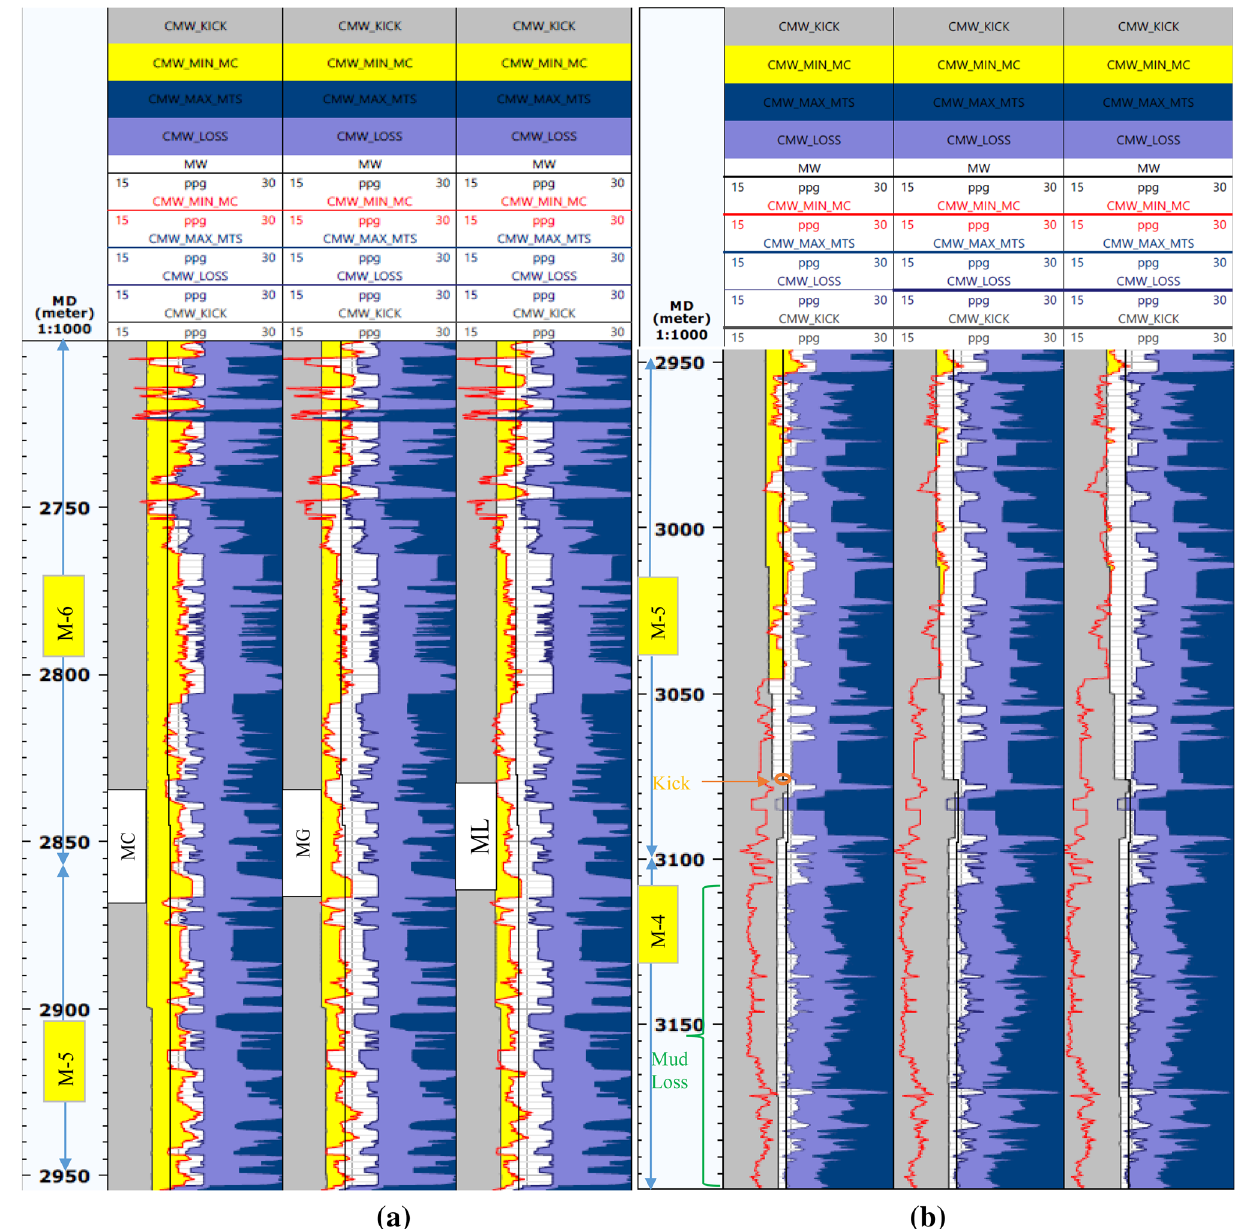
Fig. 13 a Safe mud weight window for Gachsaran formation (Kupal field, well Z26) using several shear failure criteria: Mohr–Coulomb, MC; Mogi–Coulomb, MG; and Modified Lade, ML (2700–2950 m). CMW_Kick shows the mud weights region where kicks can occur; CMW_Min shows the mud weights region where shear failure can